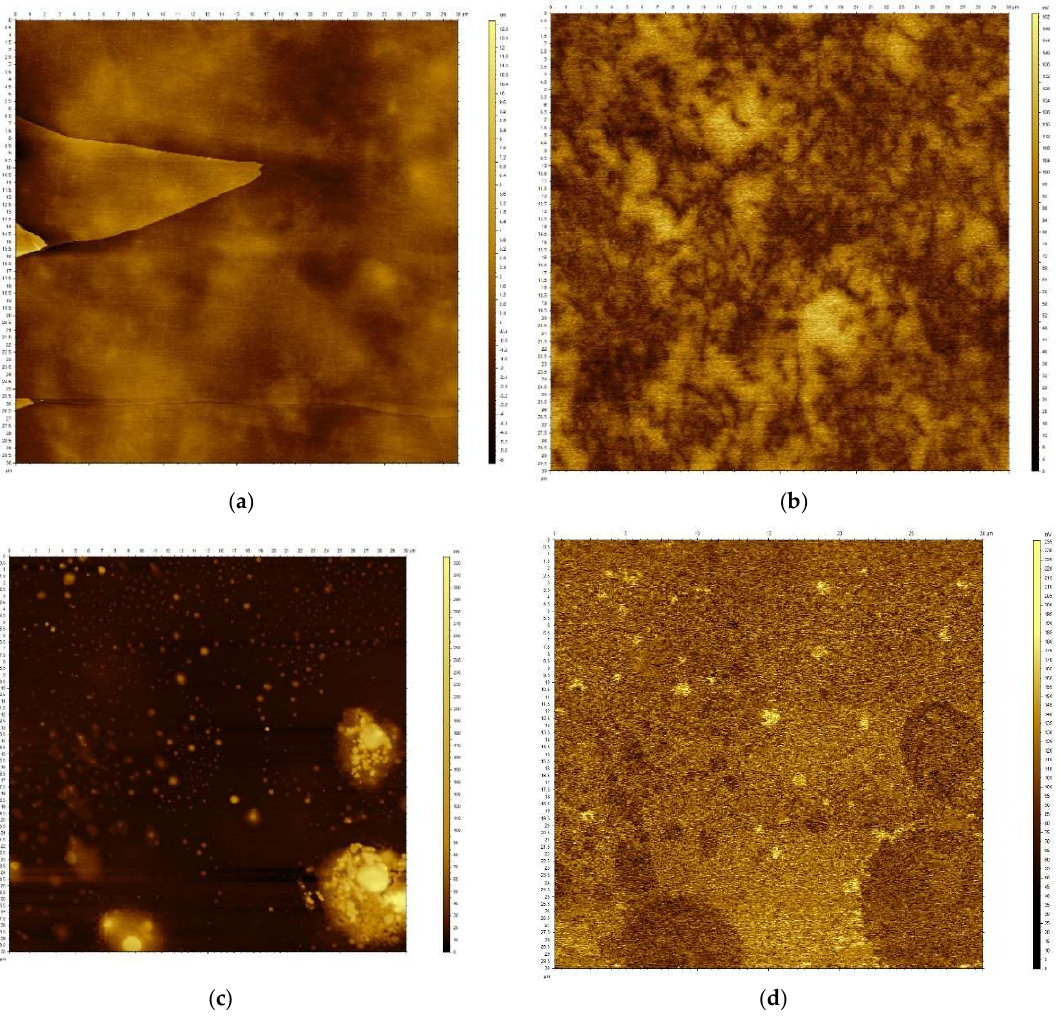
Figure 7. AFM images of the epoxy composites with 1.2 wt.% SWCNT ( a , b ) and 5 wt.% EG ( c , d ). Images ( a , c ) were obtained in topographic mode while b and d were obtained in high definition kelvin Force microscopy (HD-KFM) mode.